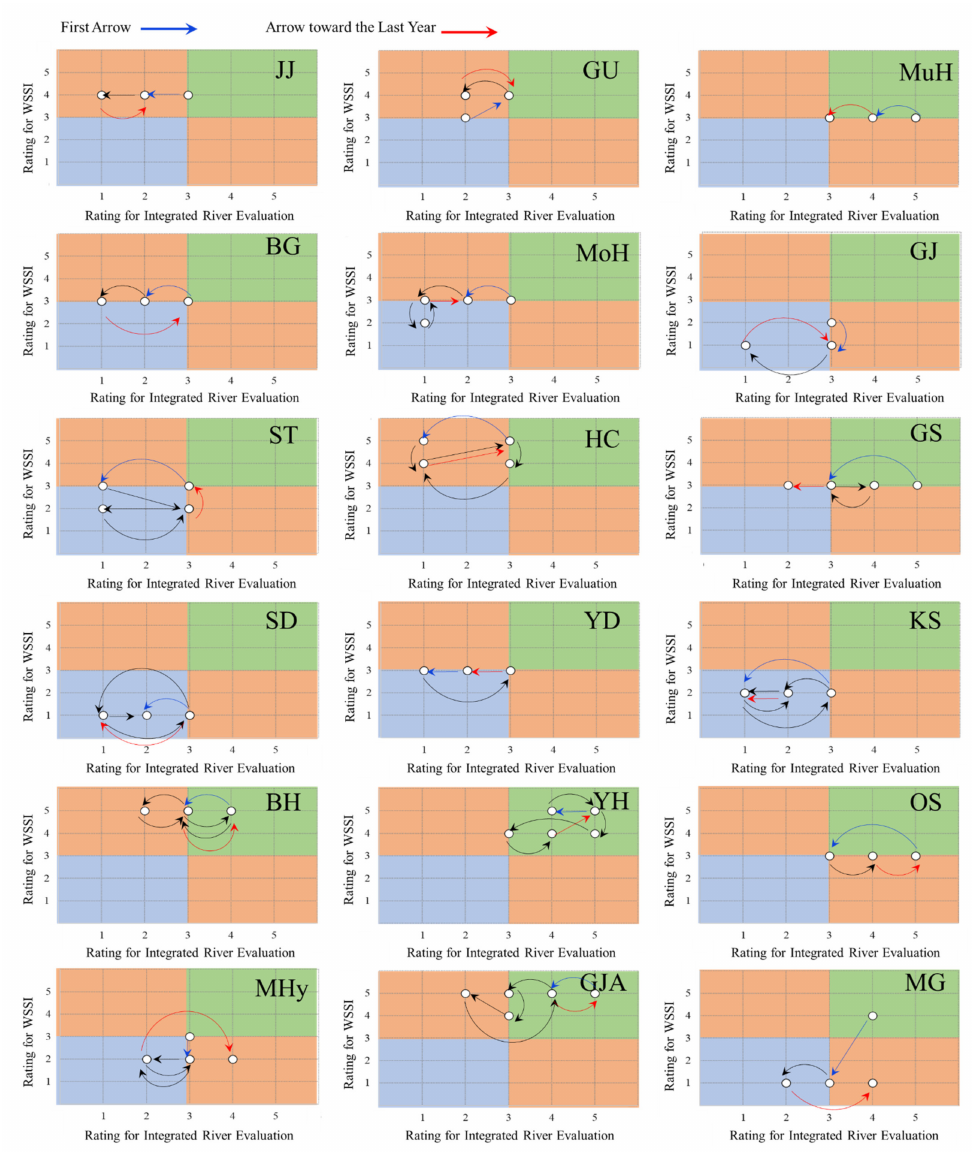
Figure 7. Results of the water management comprehensive evaluation using matrix analysis during the study